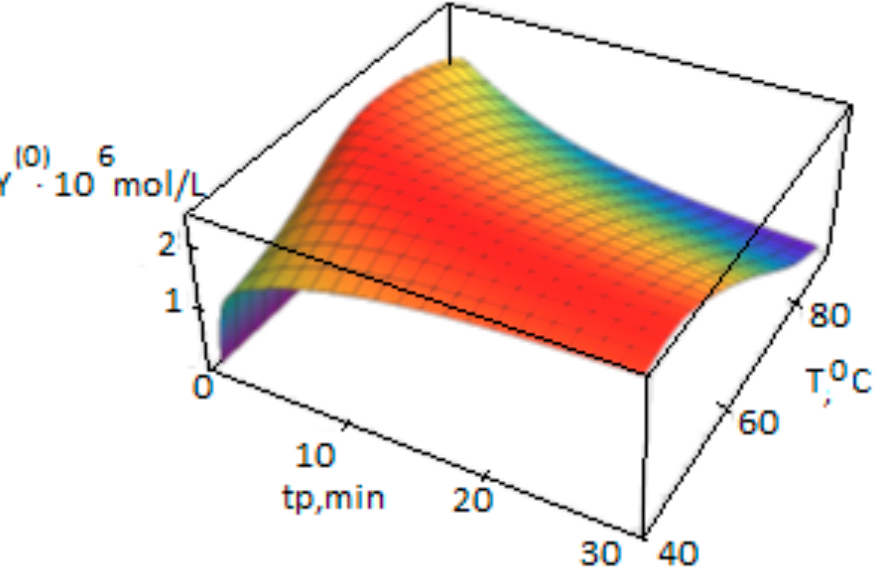
Figure 2. Dependence of the AC concentration Y ( 0 ) , mol/L, on the temperature T and the polymer- ization duration t p , calculated according to the polycenter model using the growth, activation, and deactivation energies from Table 3 (polymerization conditions in Table 1).